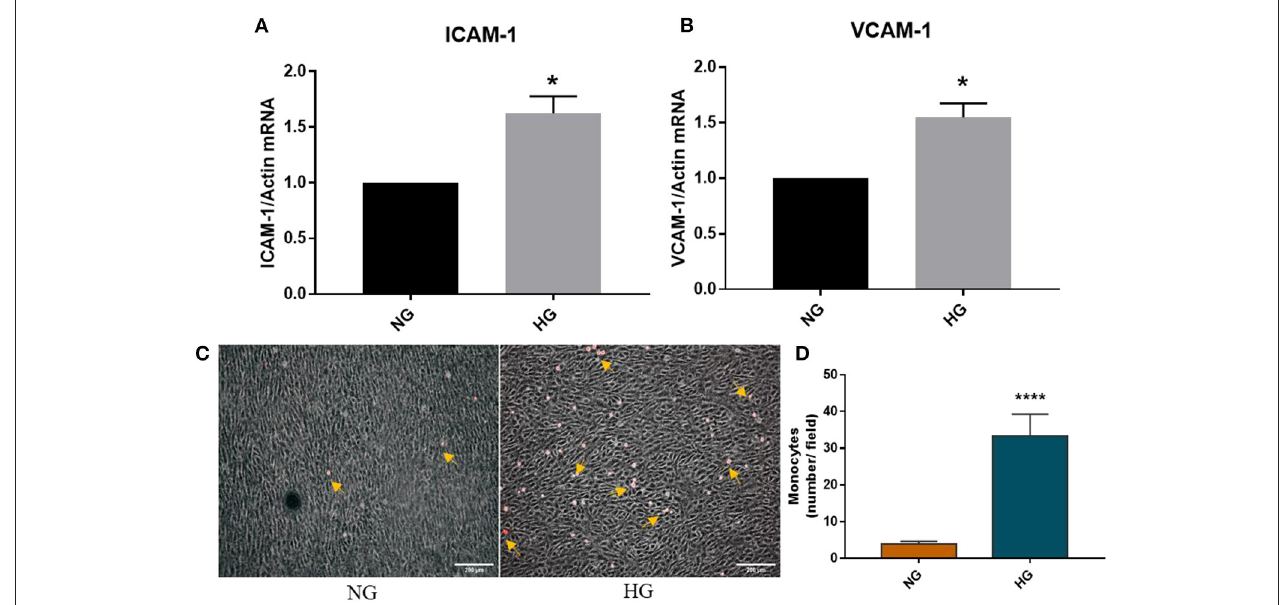
FIGURE 7 | HG induced an adhesive phenotype in VEC in the 3D ARdH model. (A,B) Gene expression of ICAM-1 and VCAM-1 in VEC from 3D-constructs exposed to NG or HG for 7 days, as evaluated by Real-Time PCR. n = 4, * p < 0.05 NG vs. HG. (C,D) Cell adhesion of THP-1 monocytes (yellow arrows) to the endothelial monolayer (phase contrast) on 3D constructs exposed to NG or HG, in laminar flow condition. The number of firmly attached monocytes to HG-exposed 3D constructs was 7 times higher compared with control NG. **** p < 0.0001 vs.